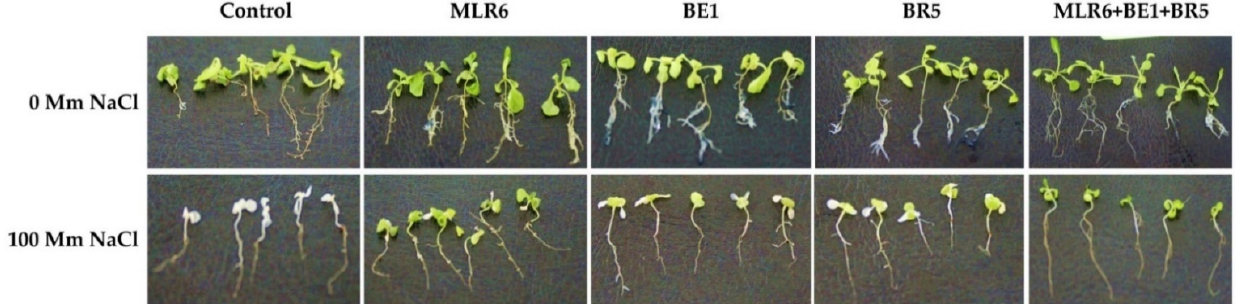
Figure 8. In vitro effect of bacterial isolates on Arabidopsis seedlings growth exposed to NaCl (0, 100 mM) concentrations.